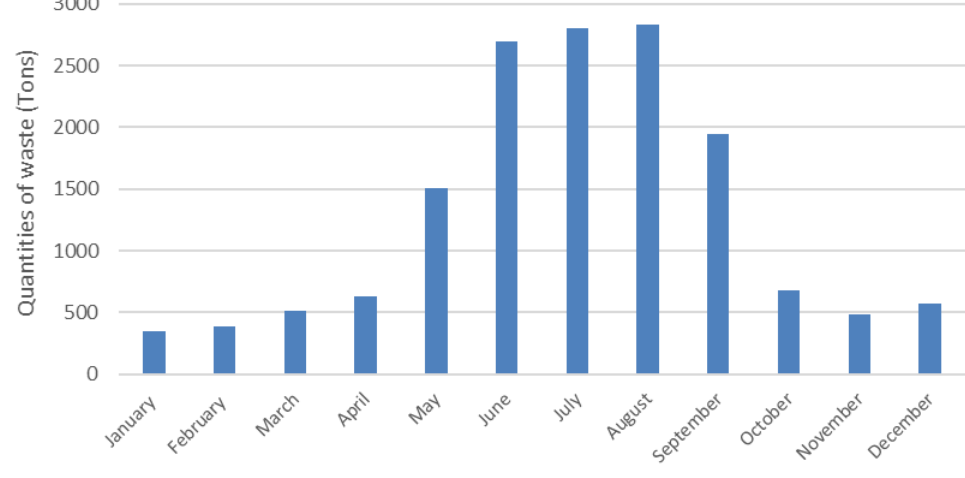
Figure 4. Evolution of SW attributable to tourism (tons/month) in Hammamet (2017).